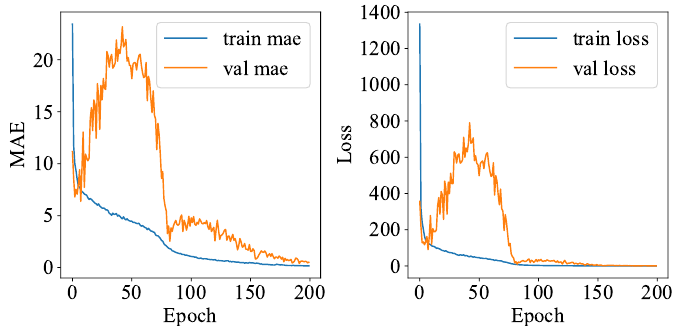
Figure 18. MAE and Loss training curves. Figure 19 is a scatter plot with histograms of the real latitude and longitude and predicted latitude and longitude of thunderstorm weather samples in validation set. Each point represents the difference between the predicted and actual values of latitude and longitude for a given sample, and the closer to the origin (0, 0), the smaller the error is and the more accurate the lightning is located. The latitude and longitude sent to the network for training are normalized beforehand to eliminate the influence of the magnitude between the data, and the straight line in the graph represents the regression line of the difference in longitude and the difference in latitude (with slope close to 1). Through two histograms, it can be clearly seen that for most of the thunderstorm samples, the model performs well for lightning center localization, with longitude error controlled within ± 0.25 and latitude error controlled within ± 0.2.